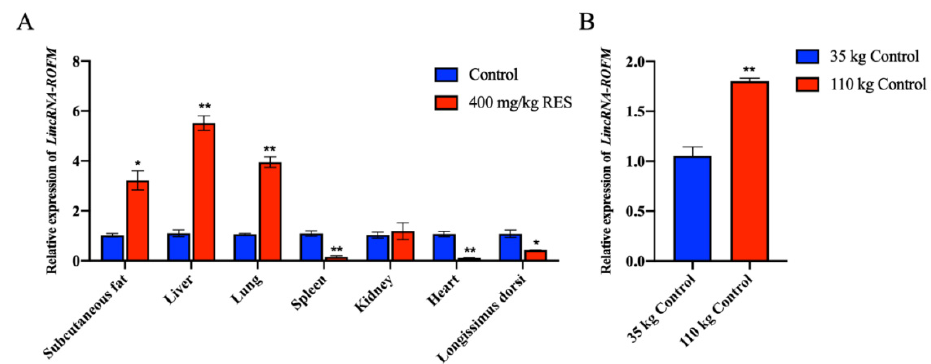
Figure 2. LincRNA-ROFM is highly expressed in pig liver and affected by fat deposition and RES. ( A ) The expression profiles of LincRNA-ROFM in porcine subcutaneous fat in control and 400 mg/kg RES groups as detected by RT-qPCR assay . The tissues corresponding to the control group were used as controls . ( B ) The expression profiles of LincRNA-ROFM in porcine subcutaneous fat in 35 kg and 110 kg control groups as detected by RT-qPCR assay. Data are presented as the mean ± SEM (n = 3) vs. control, * p < 0.05, ** p < 0.01.